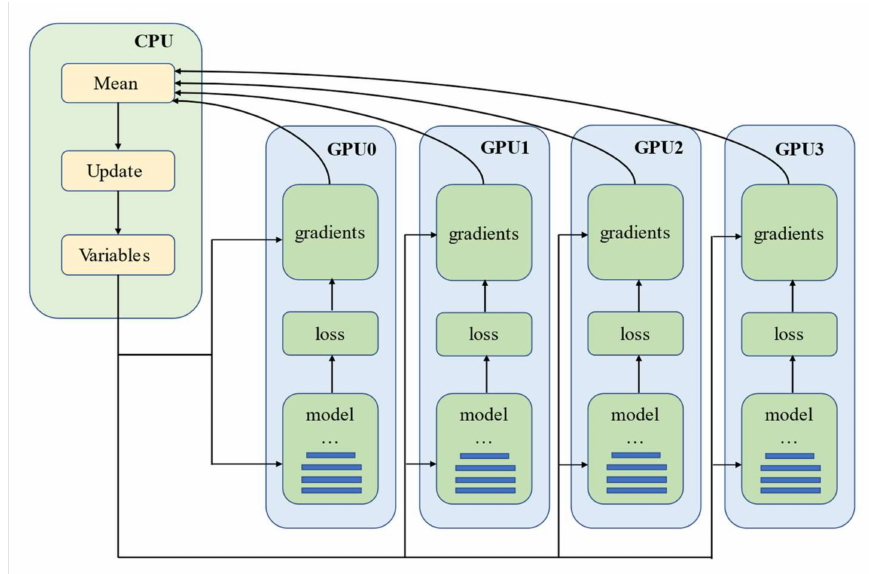
Figure 6. The data flow of multi-GPU